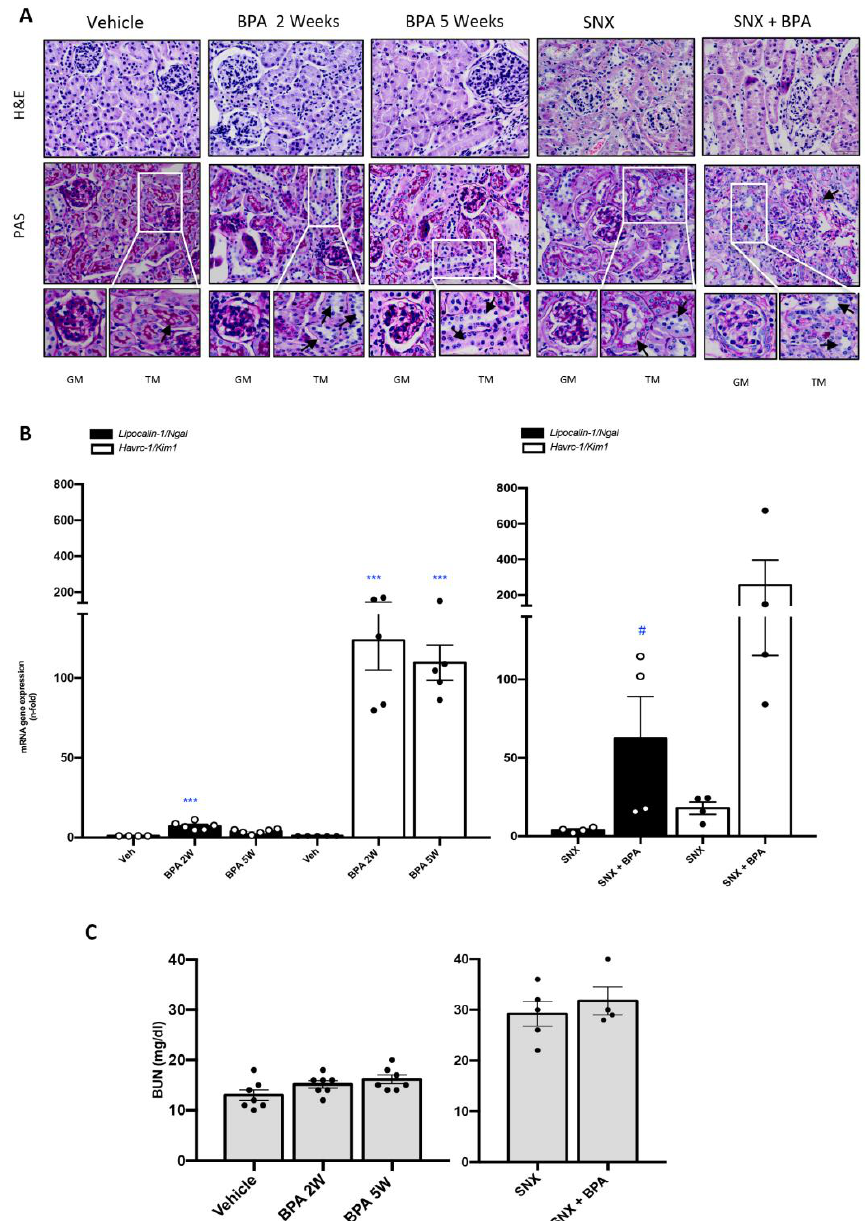
Figure 1. Systemic chronic administration of BPA induces kidney damage in healthy mice and exacerbates renal lesions in an experimental model of progressive CKD. Animals were intraperitoneal (i.p) injected with 120 mg/kg/day BPA (5 days a week) or vehicle (corn oil) and sacrificed after 2 or 5 weeks. Some animals were subjected to subtotal nephrectomy (SNX), then treated or not with BPA and sacrificed after 5 weeks. ( A ) Representative pictures of H&E and PAS staining show tubular dilatation, mesangial matrix proliferation, glomerulus disorganization and loss of glomerular/tubular basement membrane and the brush border of the proximal tubules in animals exposed to BPA mainly in SNX compared to vehicle mice. Magnification 200 × (GM: glomerular magnification; TM: Tubular magnification; arrows indicate tubular damage /scale bar appears in lower right area of the image and represents 50 µ m). ( B ) Renal mRNA expression of Havcr-1/Kim-1 and Lipocalin2 (that codify KIM-1 and N-GAL, respectively) were evaluated by RT-PCR. ( C ) Serum Urea Nitrogen (BUN) levels are shown in mg/dl. All data are presented as the mean ± SEM of 4–7 mice per group; *** p < 0.001 vs. Vehicle, # p < 0.05 vs. SNX. Comparison between SNX and SNX + BPA groups was performed using a parametric unpaired two-sided t test. The analysis of WT vs. BPA-treated groups was done by one-way ANOVA, followed by the Tukey HSD multiple comparison